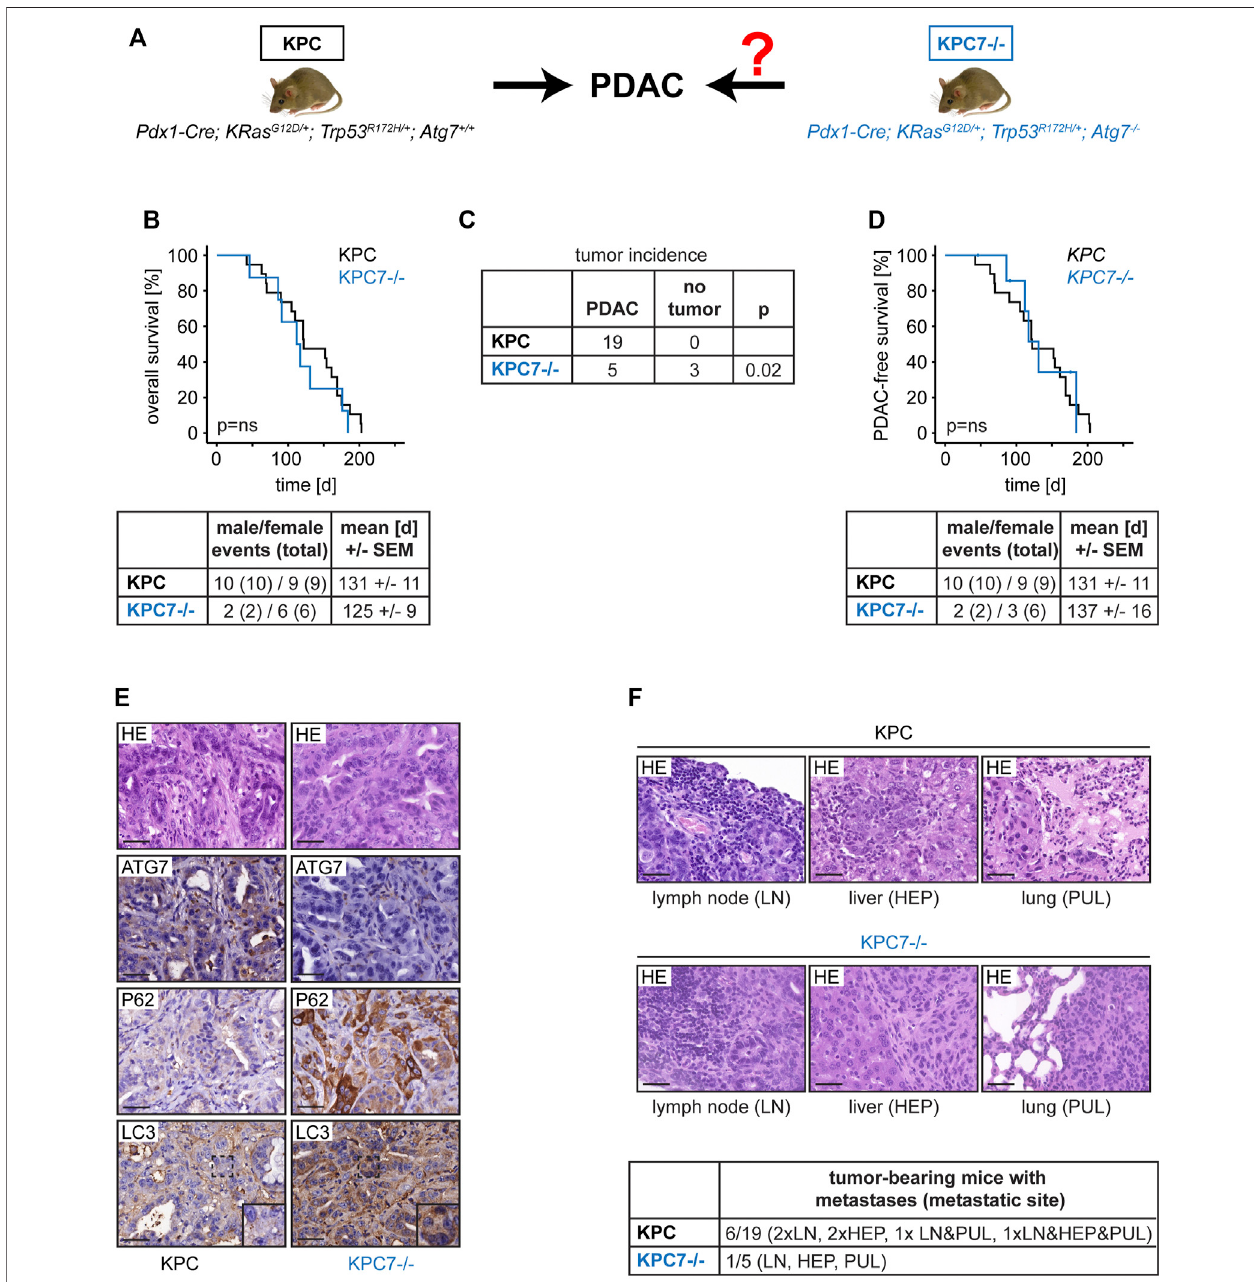
FIGURE 1 | Effects of autophagy blockage on PDAC development in the context of mutant Trp53. (A) Mouse cohorts and scienti fi c question. (B) Overall survival and cohort composition. (C ) Tumor incidence of the indicated cohorts. (D) PDAC-free survival and cohort composition. (E) Representative PDAC histology and immunohistochemistry as indicated. Scale bars represent 40 µm. (F) Metastases frequency and exemplary histology. Scale bars represent 40 µm. Statistics: Log-Rank Test (B and D) , Fisher ’ s Exact Test (C) , ns = not signi fi cant.